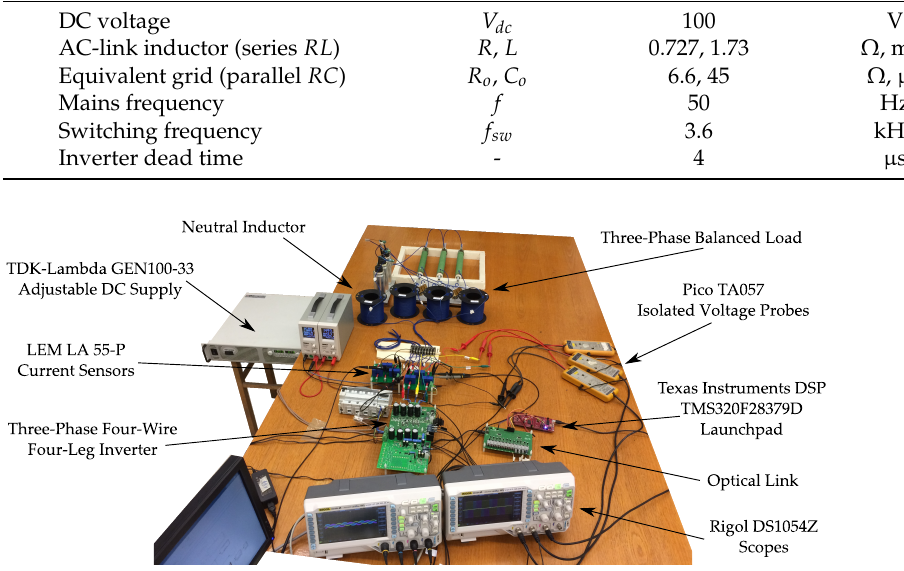
Figure 7. View of the laboratory test bench together with the devices used for control and